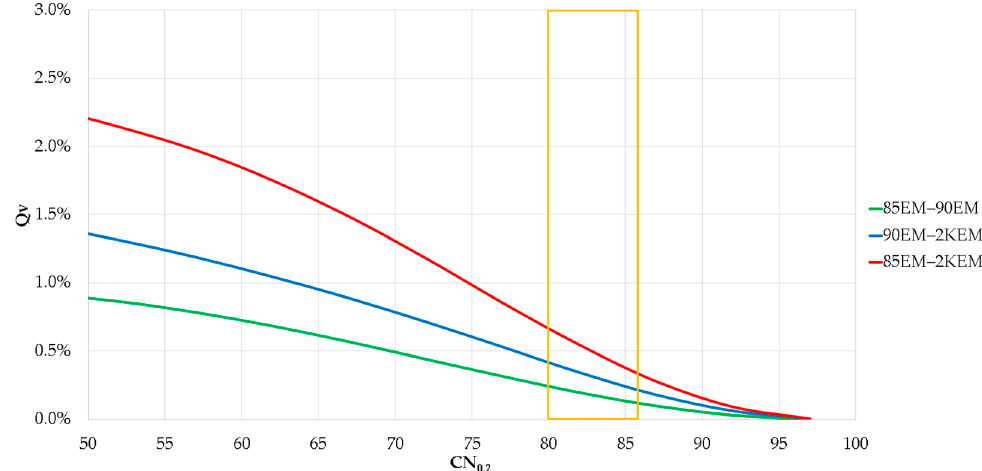
Figure 4. The decadal runoff trend for the interdecadal runoff difference between 85EM and 90EM, 90EM and 2KEM, and 85EM and 2KEM. The yellow box highlights the 99% BCa confidence interval of CN 0.2 for the East Malaysia dataset, in the range of 80–86. Table 5. The optimum S, optimum CN 0.2 , and its corresponding BCa 99% CI for both Peninsular Malaysia and East